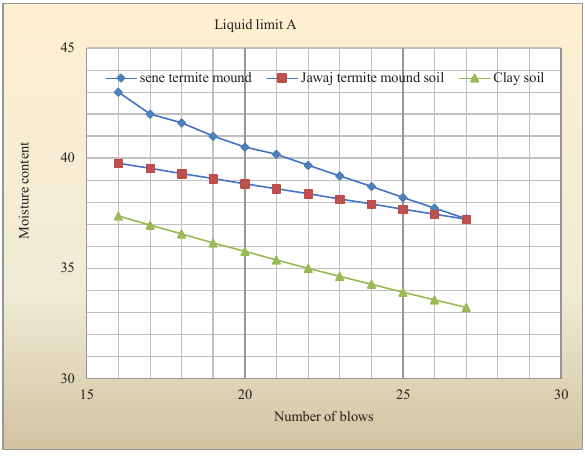
Figure 5: LL of JTMSs, STMSs and clay soils .